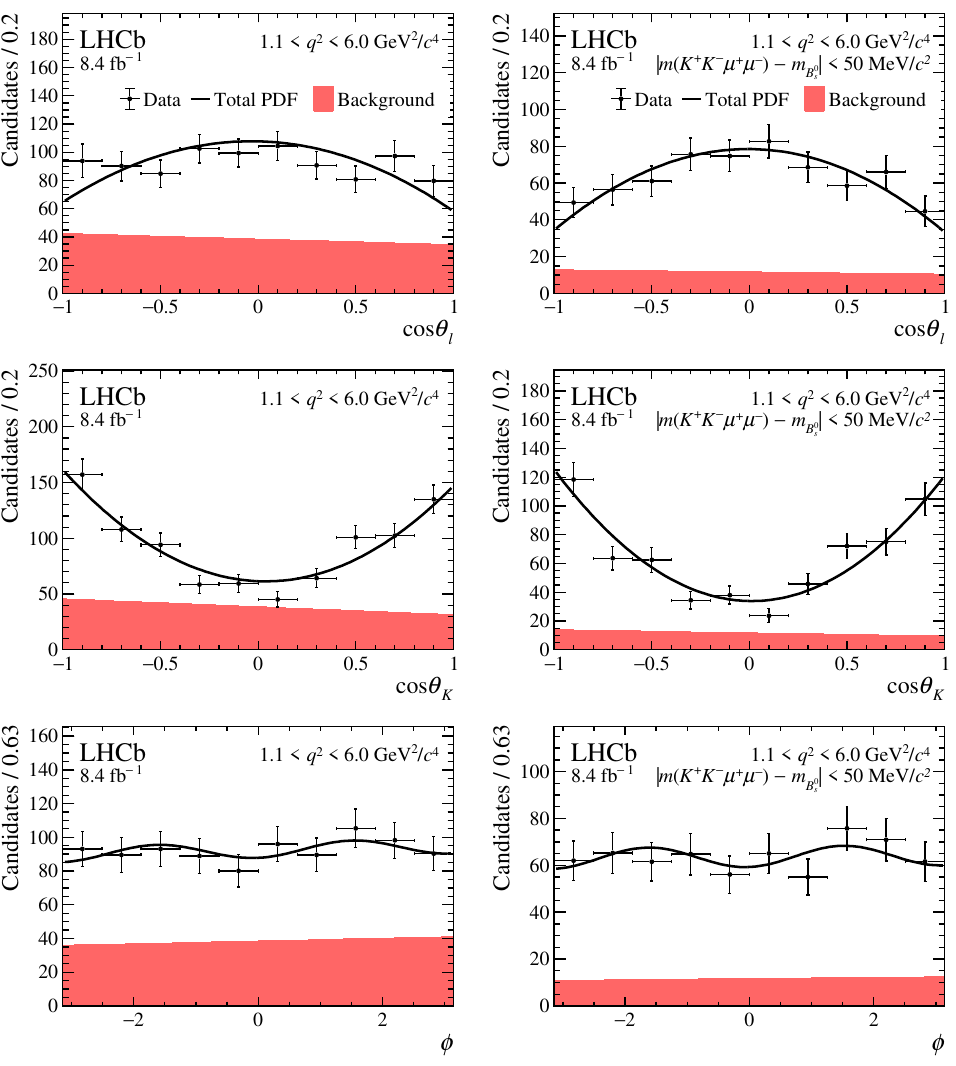
Figure 10 . Projections in the region 1 . 1 < q 2 < 6 . 0 GeV 2 /c 4 for the angular distributions of the combined 2011–2012, 2016 and 2017–2018 data sets. The data are overlaid with the projection of the combined PDF. The red shaded area indicates the background component and the solid black line the total PDF. The angular projections are given for candidates in (left) the entire mass region used to determine the observables in this paper and (right) the signal mass window ± 50 MeV/ c 2 around the known B 0 s